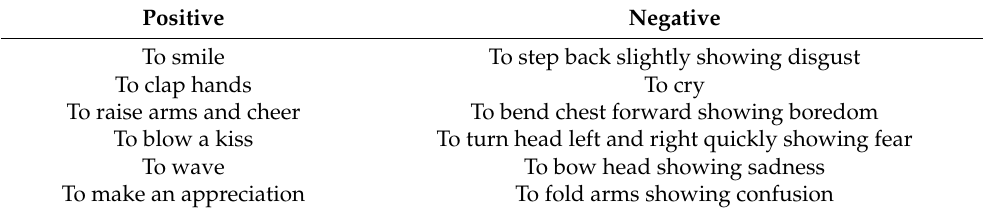
Table 1. Robot actions performed according to positive or negative images